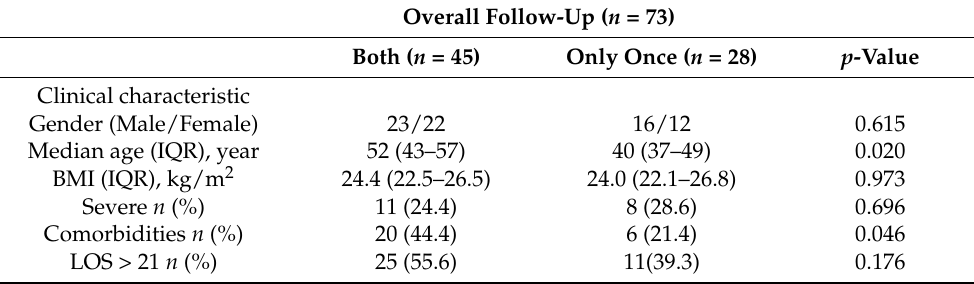
Table 1. Demographic characteristics of the subjects with who attended both follow-ups and only once follow-up.